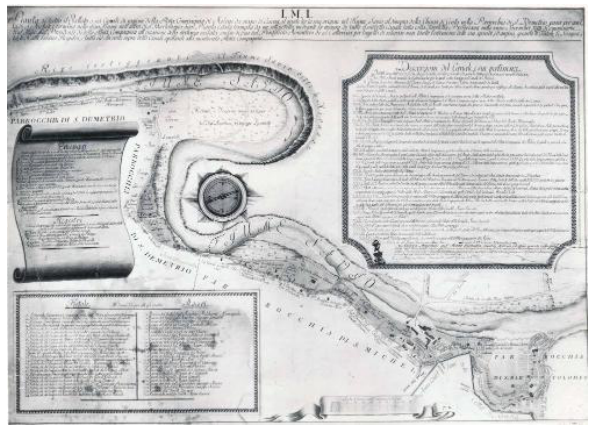
Figure 3. Papal bull for the sale of the mills to the company,